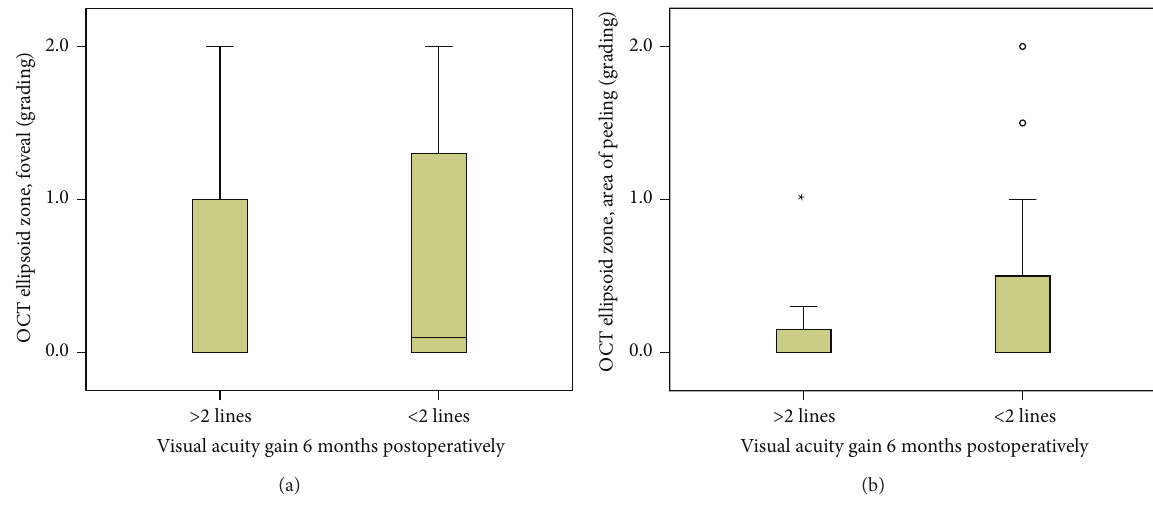
Figure 4: (a) Correlation of preoperative foveal EZ grading and gain of visual acuity 6 months postoperatively. No significant difference between groups ( 𝑝 > 0.05 ). (b) Correlation of preoperative EZ grading in areas of peeling and gain of visual acuity 6 months postoperatively. No significant difference between groups ( 𝑝 > 0.05 ).